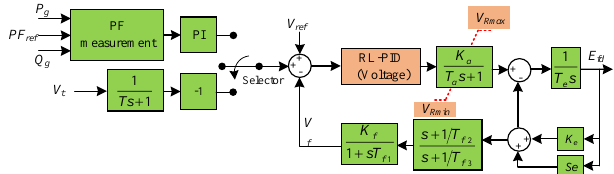
Figure 14. The modified IEEE’s type AC5A with secondary voltage